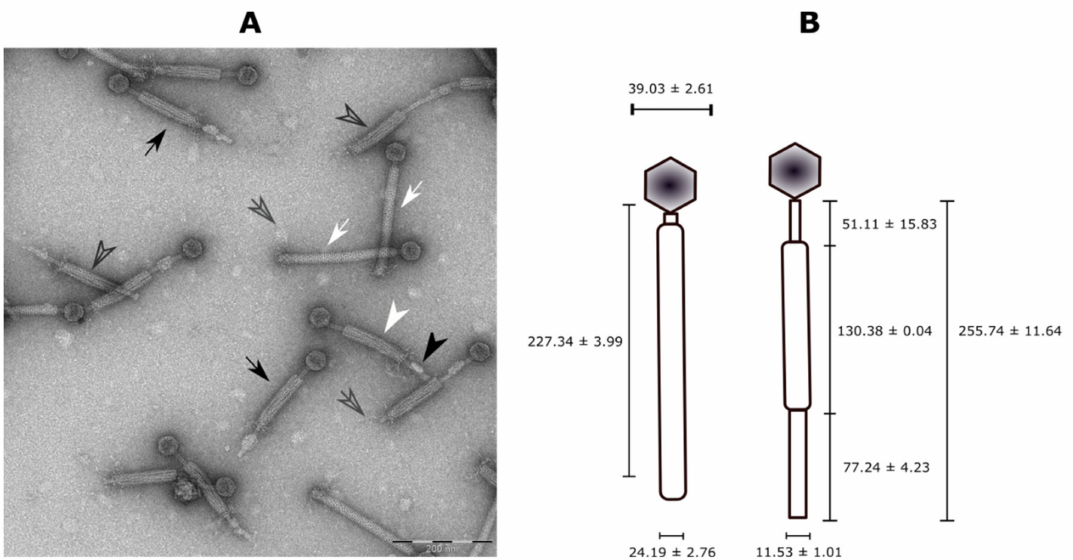
Figure 8. ( A ) Transmission Electron Microscopy (TEM) of partially purified Bp15.1PLPs by sucrose gradient. Two different forms were observed, an extended particle (white arrows) and a contracted form (black arrows). In the contracted form, a tail tube (black arrowhead), a tail sheath (white arrowhead) and fibres at the end of the tails (empty arrows) were distinctly observed. Some of the particles lacked a head (empty arrowhead). ( B ) Schematic representation of the observed phage-like particles with the average size of each part (obtained from at least three measurements).